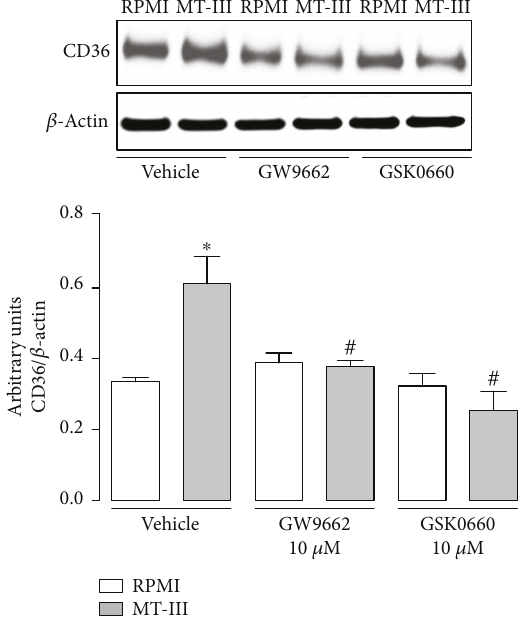
Figure 7: MT-III-induced CD36 protein expression is dependent on PPAR- γ and PPAR- β / δ activation. Peritoneal macrophages were incubated with GW9662 (10 μ M) or GSK0660 (10 μ M) compounds or vehicle ( < 1% DMSO/RPMI) for 1h and then with MT-III (0.4 μ M) for 6 h. Western blotting and densitometric analysis of CD36 receptor and β -actin (loading control) in macrophage extracts. The densities (in arbitrary units) were normalized with those of β -actin. Results are expressed as mean ± SEM from three experiments. ∗ p < 0 05 compared with controls; # p < 0 05 compared with vehicle-treated MT-III-stimulated